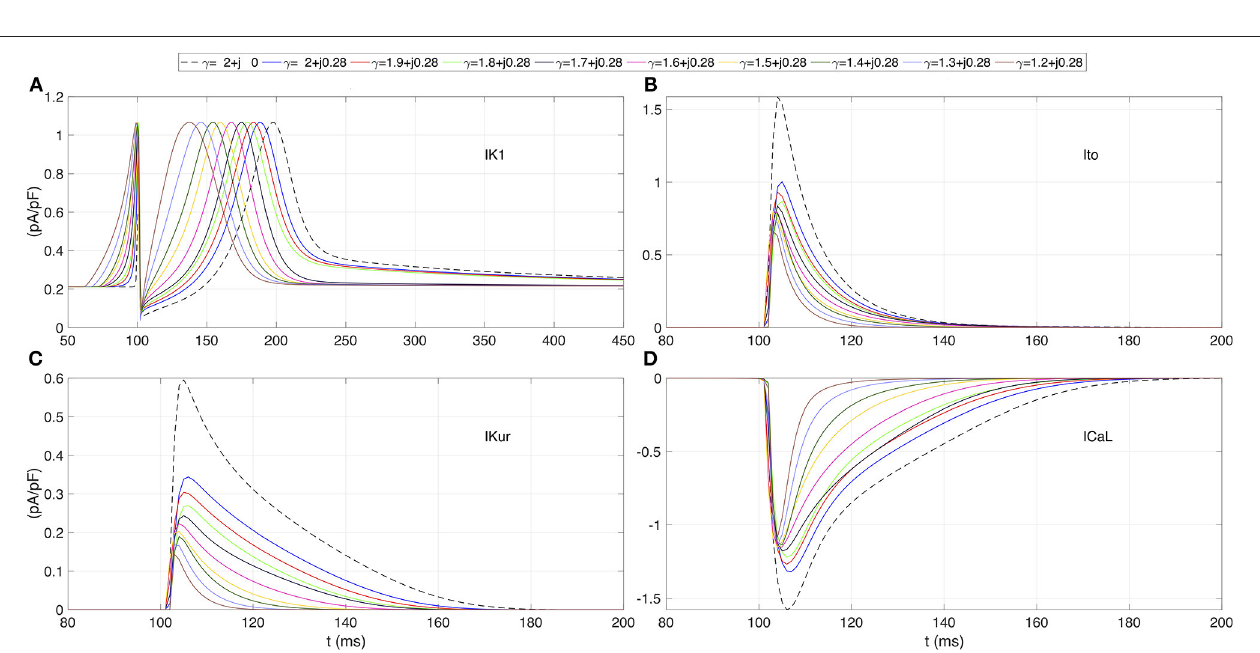
FIGURE 1 | (A) Courtemanche’s action potential registered at the center of the atrial strand under CAF conditions. Dashed line corresponds to standard diffusion and colored curves correspond to test values of γ . (B) APD map over the ( α , β ) plane. (C) Sodium peak current map over the ( α , β ) plane. White means that no record is obtained due to absence of propagation.